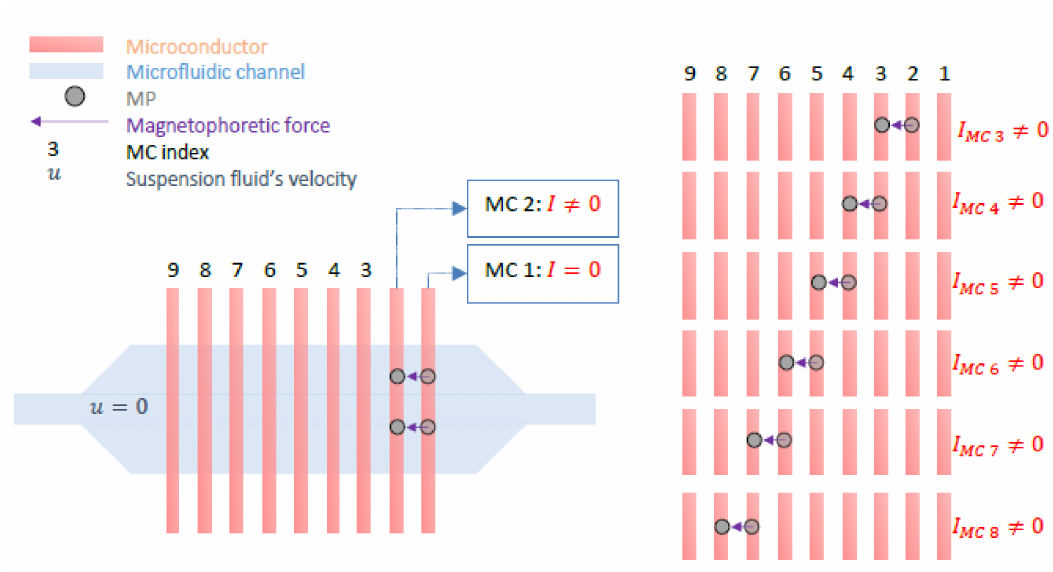
Figure 2. Schematic of the developed reference microfluidic channel with the integrated microconductors (MCs). A MP is manipulated from the right to the left by switching the current ON and OFF on adjacent MCs. The magnetic force is always collinear to the gradient of the magnetic field. The operating principle of this microfluidic platform is described in detail in [3]. The behavior and dynamics of differently loaded MPs are observed with a video fluorescence microscope. The magnetically labeled E. coli bacteria are also labeled with a fluorophore for imaging purposes. The recorded video is converted to gray-scaled